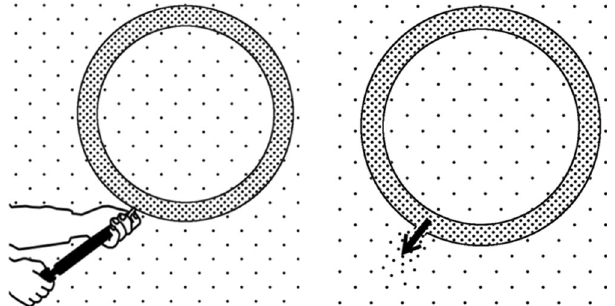
FIG. 1. The example of an inflated bicycle tire is used to illustrate that a pressure difference leads to an air flow using a particle model.